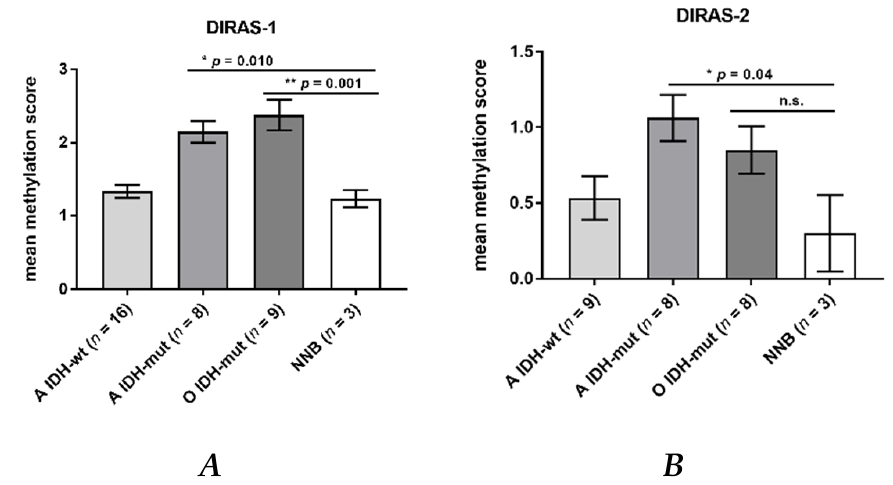
Figure 2. DIRAS-1 and DIRAS -2 CpG methylation status in gliomas and non-neoplastic brain tis- sues. ( A ) DIRAS-1 CpG island methylation scores (A: astrocytic and O: oligodendroglial tumors, IDH -wt: Wild-type IDH status, IDH -mut: mutated IDH status) and three non-neoplastic brain tis- sues. ( B ) DIRAS-2 CpG island methylation scores for 25 glioma tissues and three non-neoplastic brain tissues (n.s.: not significant). Original figure in Figure S.